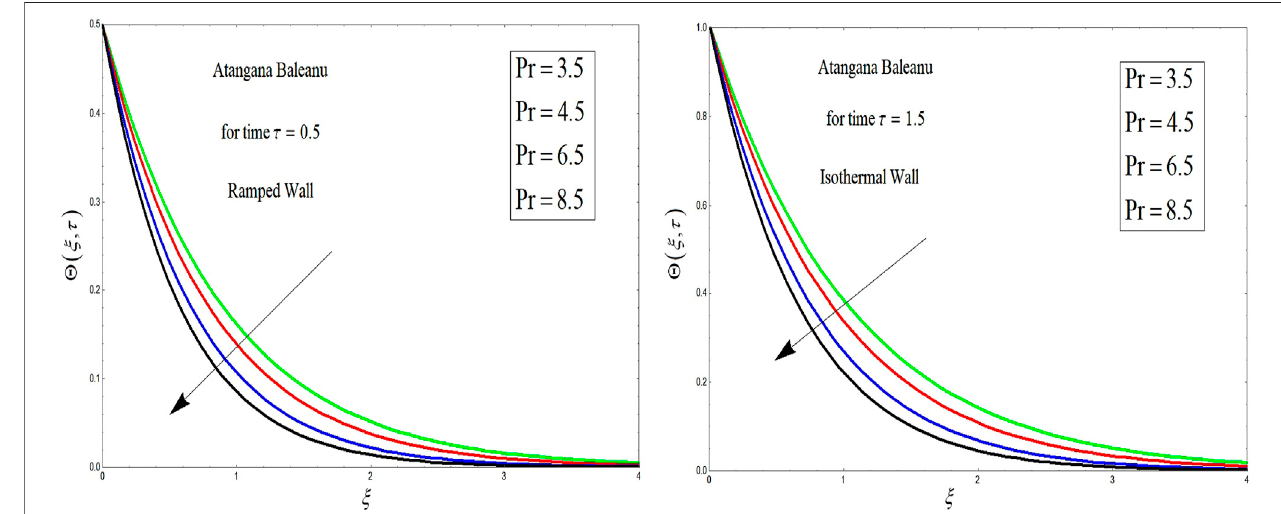
FIGURE 9 | Impact of Pr on temperature (AB fractional model).